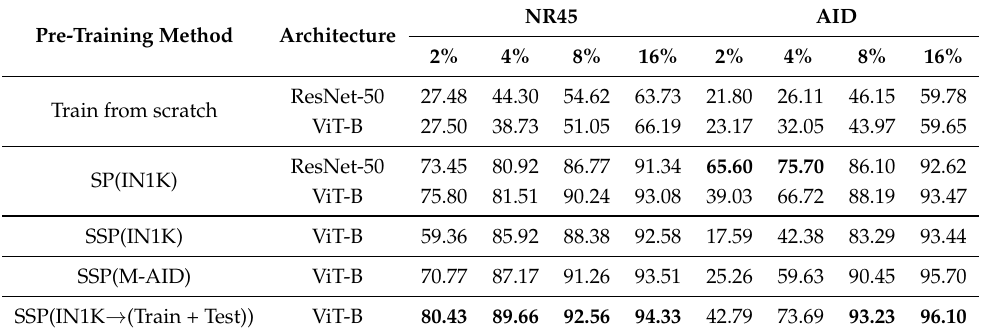
Table 3. The comparison of fine-tuning on few labeled samples.